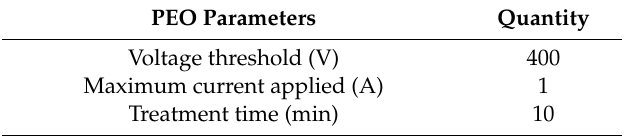
Table 1. Plasma electrolytic oxidation (PEO) parameters used during the